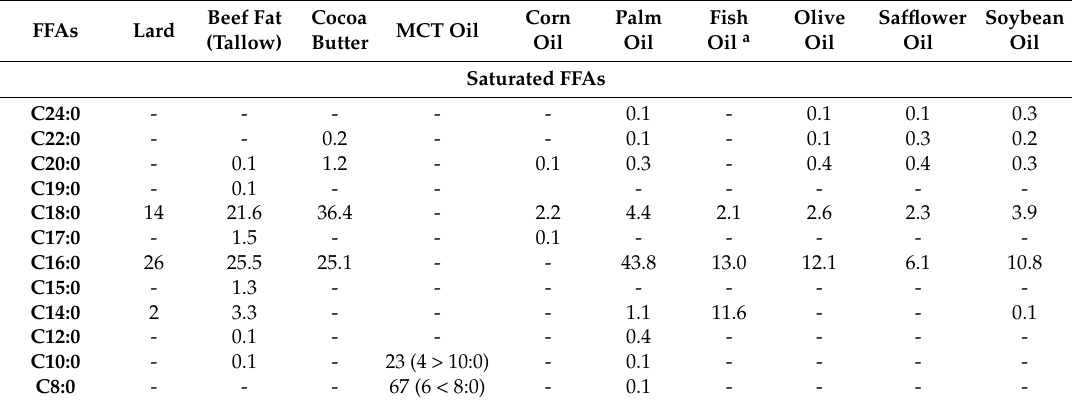
Table 2. Fatty acid composition of typical fat sources in experimental